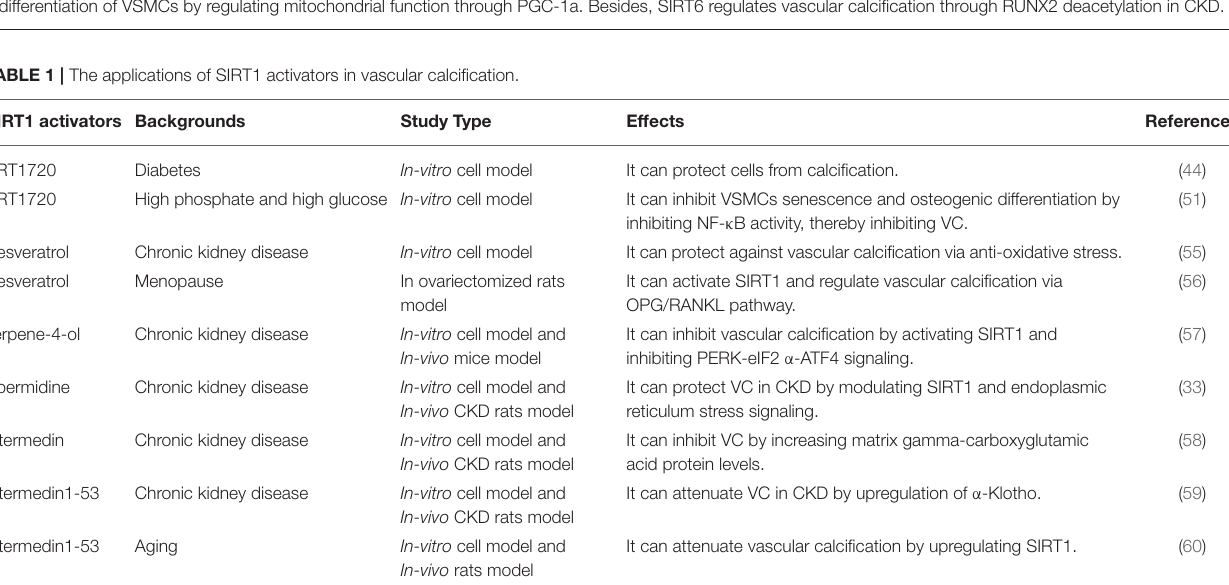
FIGURE 2 | The molecular pathways of SIRTs in vascular calcification. Regarding SIRT1, it can regulate the osteogenic differentiation of VSMCs and vascular calcification through the RUNX2/osteocalcin pathway, the Wnt signaling pathway, the DNA repair pathway, and the NF- κ B pathway. In addition, SIRT1 can alleviate the osteogenic differentiation of VSMCs by regulating the senescence of VSMCs through NF- κ B/p53/p21 pathway. As for SIRT3, it is mainly involved in the osteogenic differentiation of VSMCs by regulating mitochondrial function through PGC-1a. Besides, SIRT6 regulates vascular calcification through RUNX2 deacetylation in CKD.